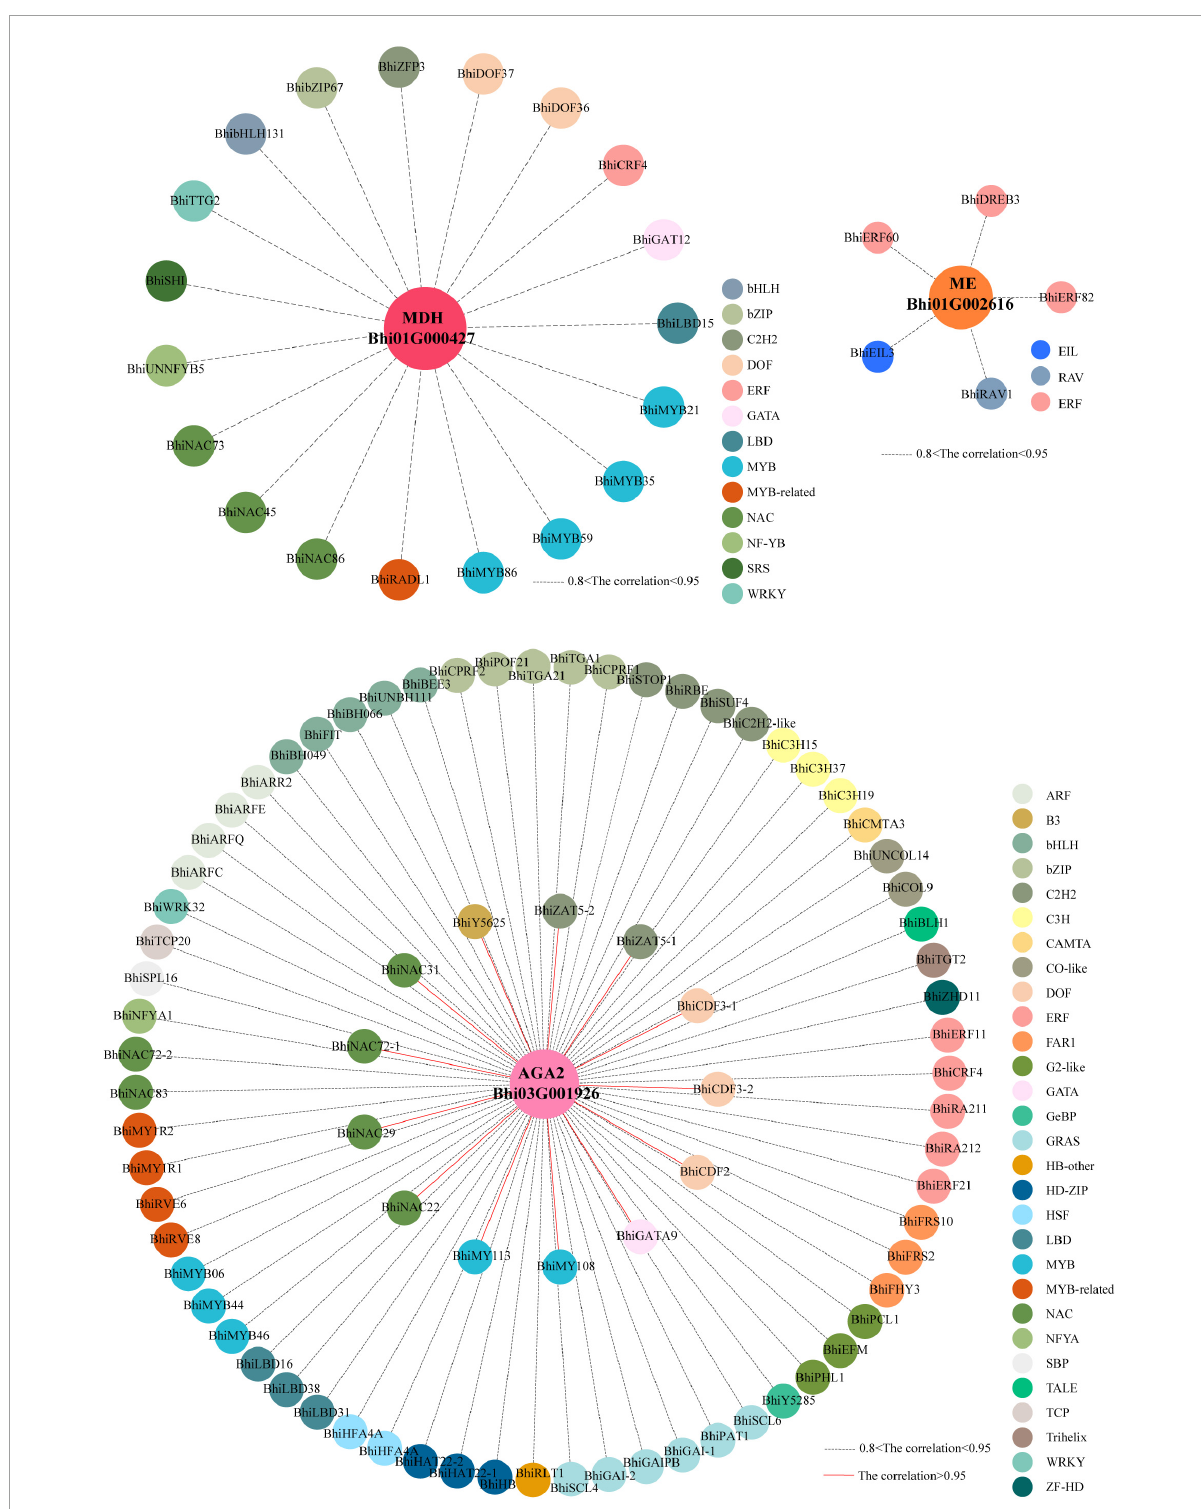
FIGURE8 Coexpression networks of TFs and enzyme genes involved in taste and nutrition metabolites. Center circles represent key enzyme genes involved in soluble sugars (pink) and malic acid (dark-pink and orange) metabolism during fruit development. Outer circles with different colors represents different families of transcription factors identified in the same module whose transcripts are correlated with expression of enzyme genes. Red lines represent correlations higher than 0.95; dotted blank lines represents correlation between 0.8 and